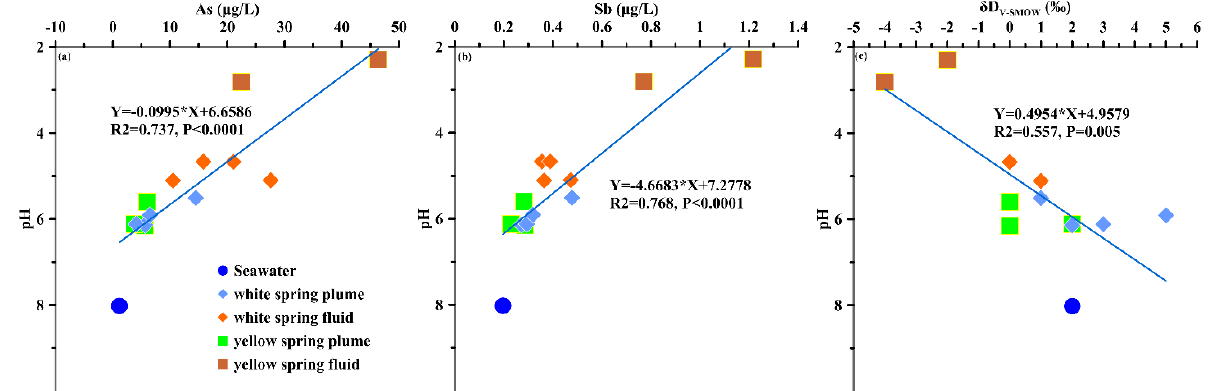
Figure 4. pH vs. As concentration ( a ), pH vs. Sb concentration ( b ) and pH vs. δ D ( c ) values for fluids and plumes in the yellow and white springs.